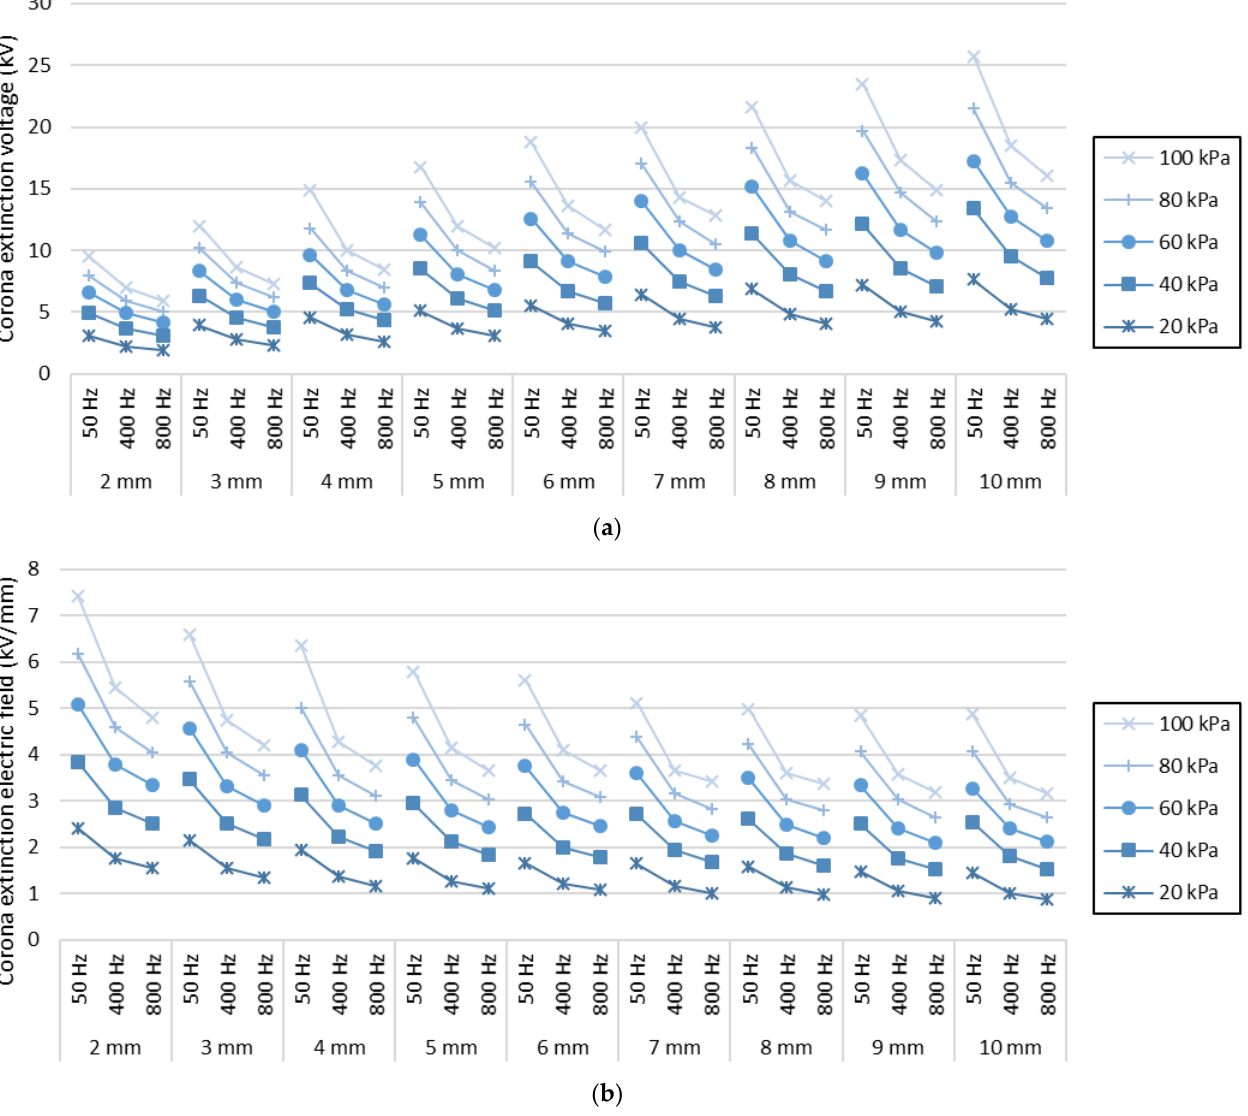
Figure 5. Visual representation of experimental values obtained from Table 1. ( a ) Corona extinction voltage. ( b ) Corona extinction electric field.